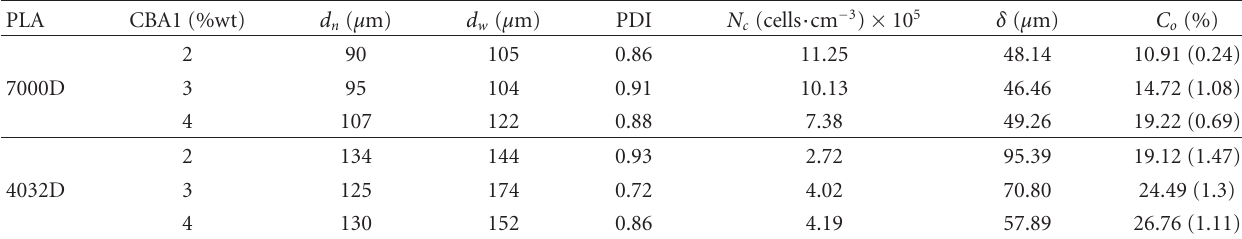
Table 13: Cell dimensions ( d n , d w ), cell size polydispersity (PDI), cell density ( N c ), cell-wall thickness ( δ ) as a function if the chemical blowing agent content (CBA1) (PLA 7000D temperature profile A and PLA 4032D temperature profile B; screw speed 30 rpm; die temperature 195 ◦ C; free cooling)—( ): standard deviation.